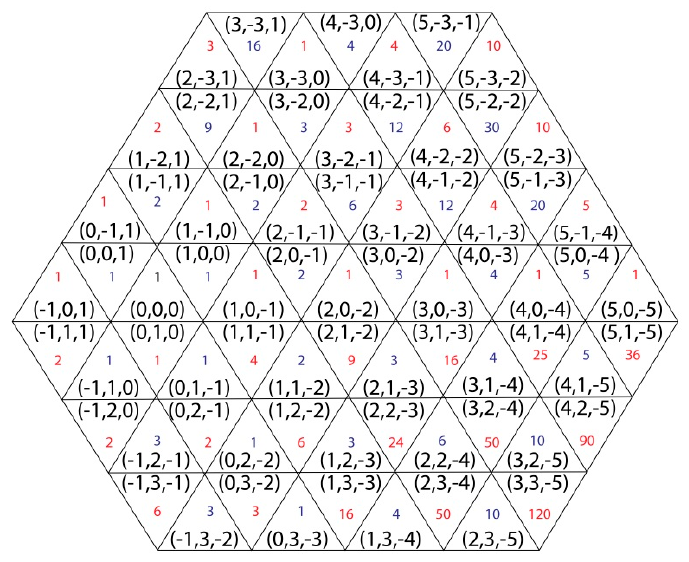
Figure 4. The number of shortest weighed paths between trixel (0,0,0) and some other trixels in the case 2 α > β and 3 α < γ .